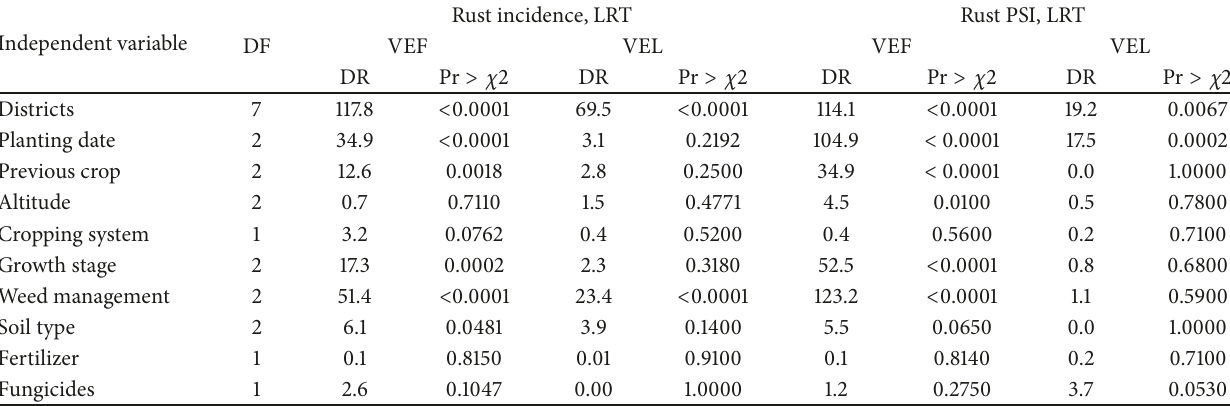
Table 7: Independent variables used in logistic regression modeling of faba bean rust incidence and percentage severity index (PSI) and likelihood ratio test (LRT) for ten variables entered first and last into a